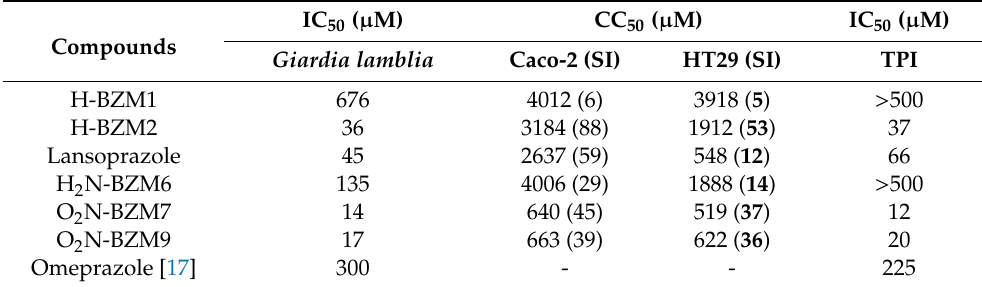
Table 1. In vitro antigiardial activities of compounds, and the cytotoxic activity on Caco-2 and HT29